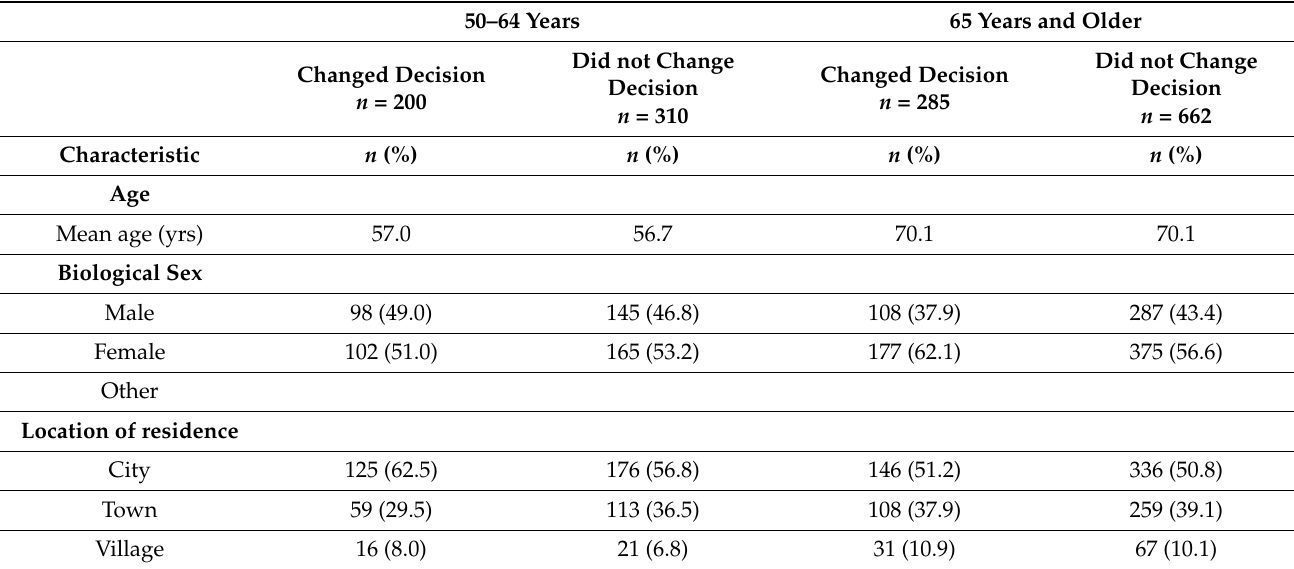
Table 2. Characteristics of respondents who originally did not intend to receive the influenza vaccine, by age